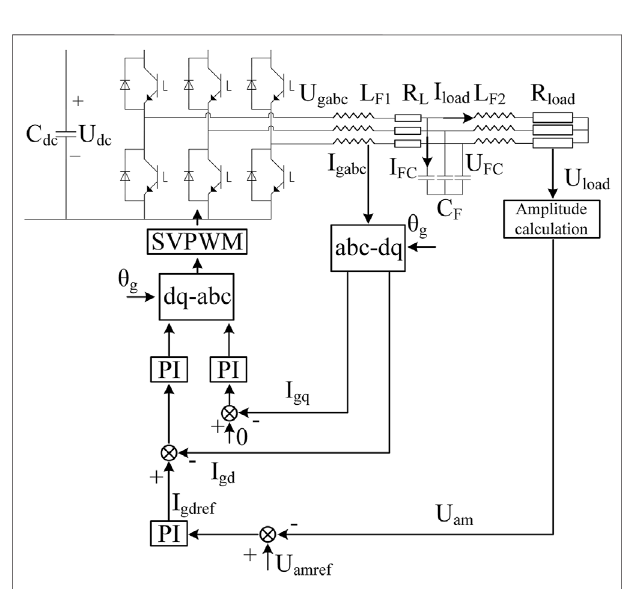
FIGURE 4 | Control strategy of the line-side